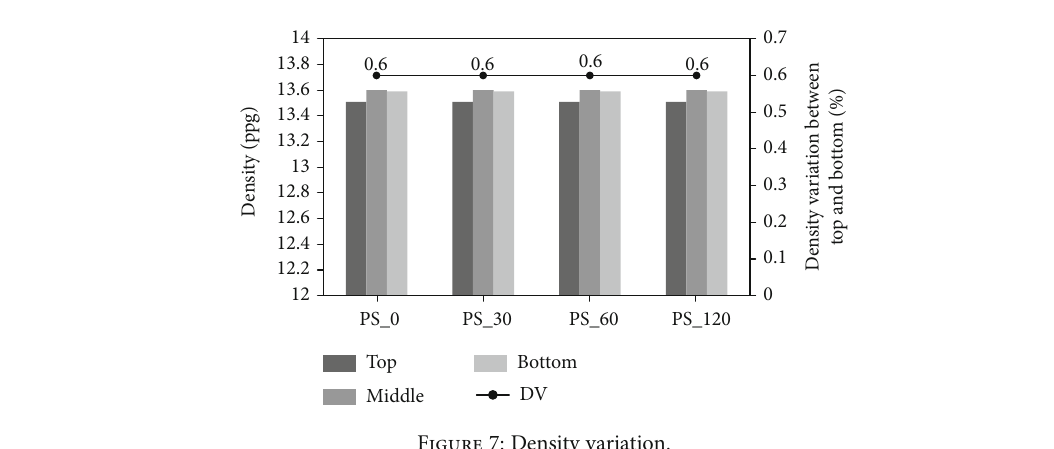
Figure 6: State of cement slurries after 2 hours of